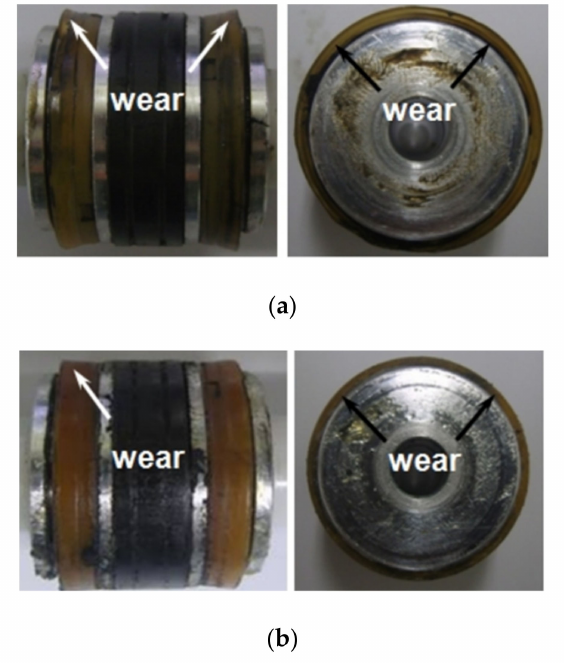
Figure 12. Unsuccessful products in field and parametric ALT: ( a ) unsuccessful products in the testing data at the field (or normal condition), ( b ) unsuccessful products after parametric